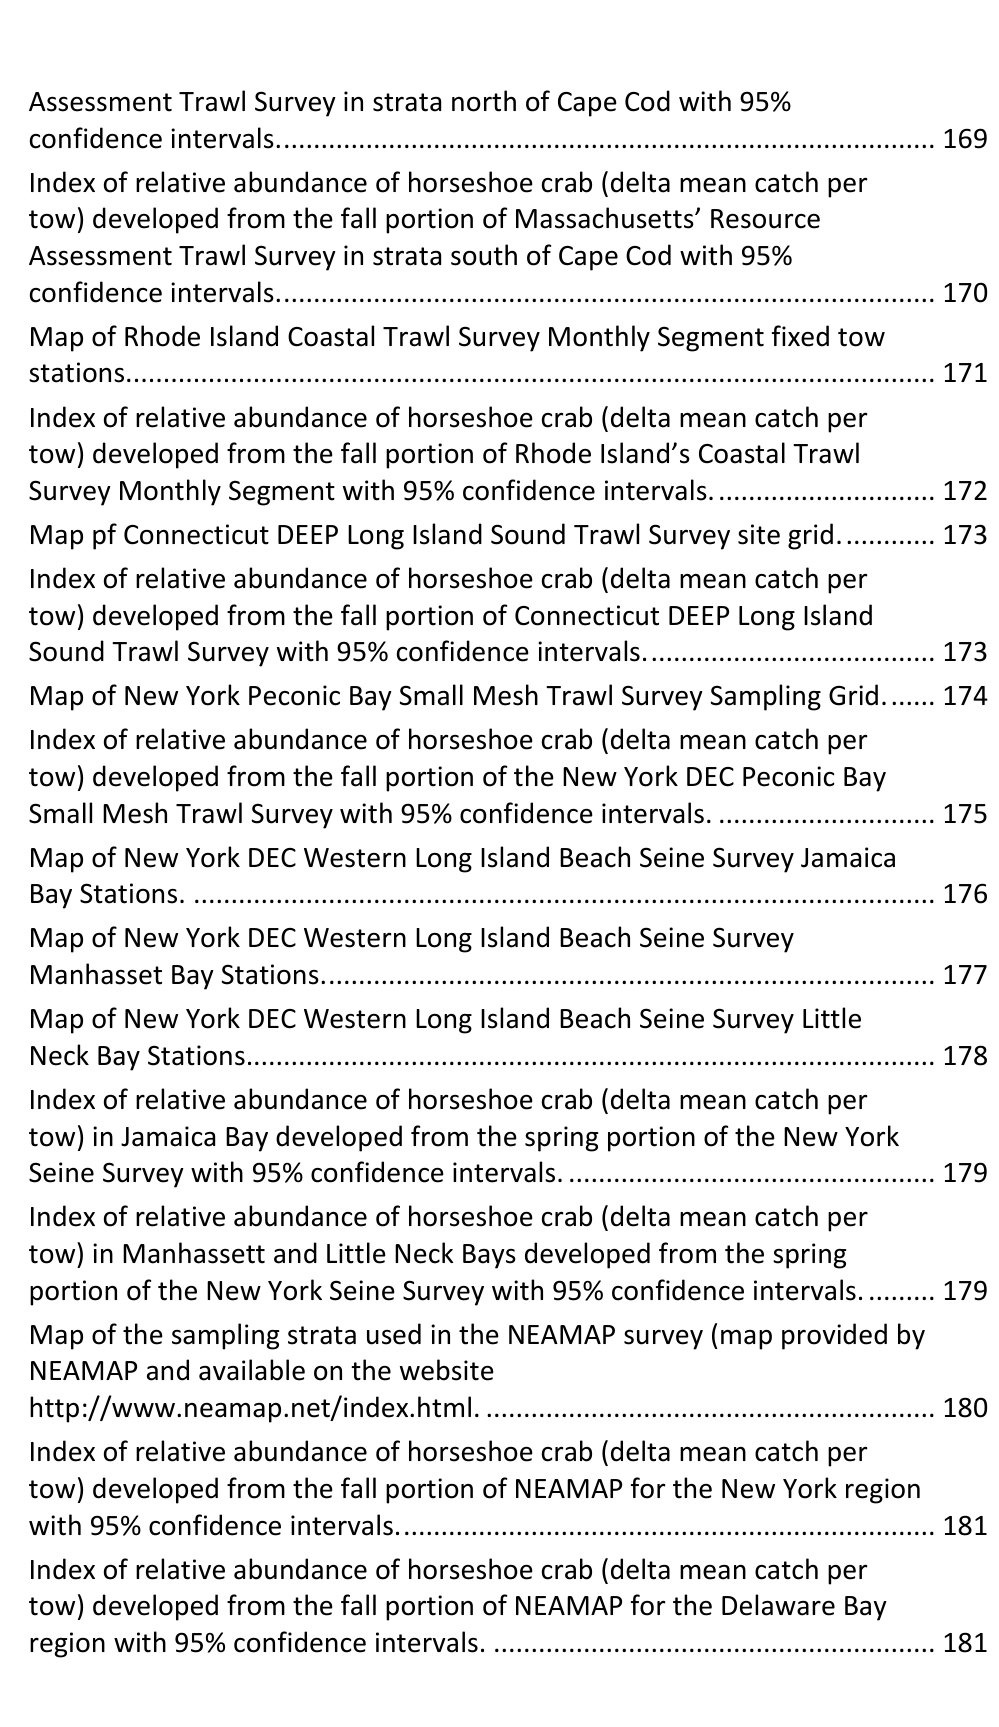
2019 Horseshoe Crab Benchmark Stock Assessment Non-Confidential Report